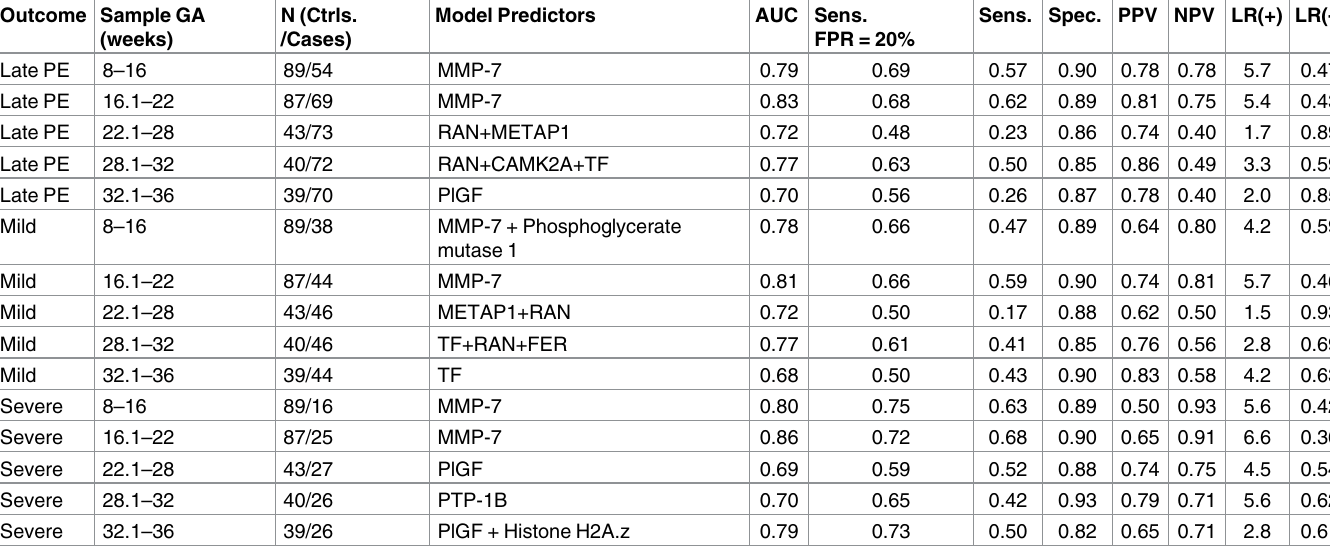
Table 2. Summaryof prediction performanceof multi-protein prediction models for late-onset, mild late-onset, and severelate preeclampsia.